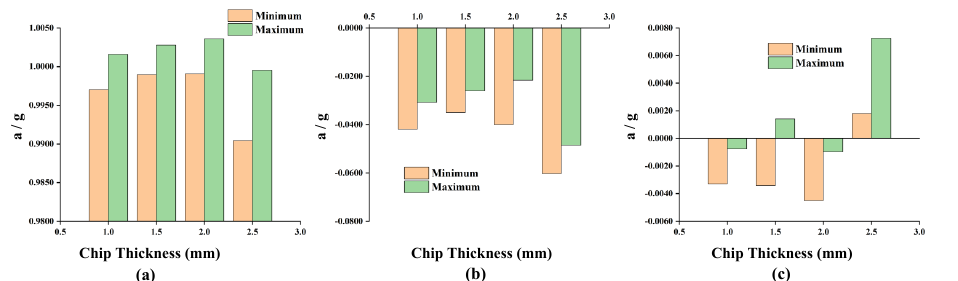
Figure 12. Range of acceleration values for different bark consumption settings. ( a ) Statistical results on the X axis. ( b ) Statistical results on the Y axis. ( c ) Statistical results on the Z